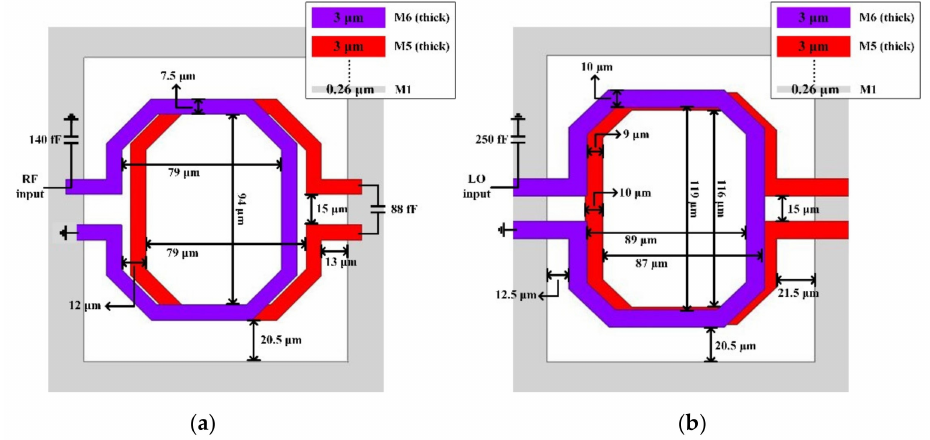
Figure 11. Transformer-based matching networks and detailed parameters, ( a ) RF port, and ( b ) LO port.